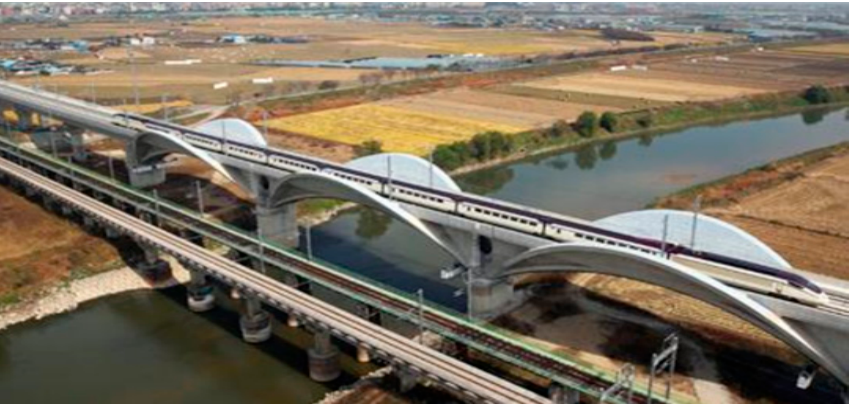
Figure 3. Structures installed with regular intervals.